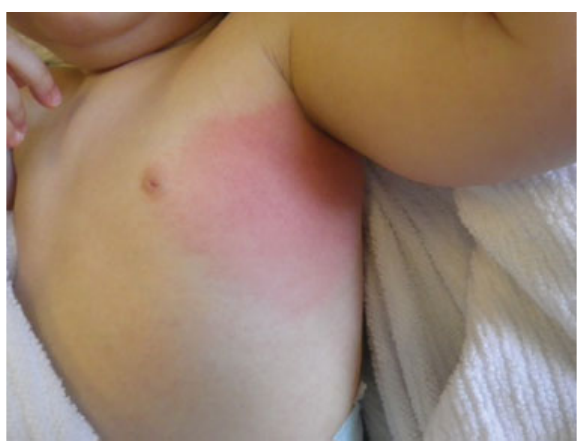
Fig. 3 Intraoperative site after cleansing.